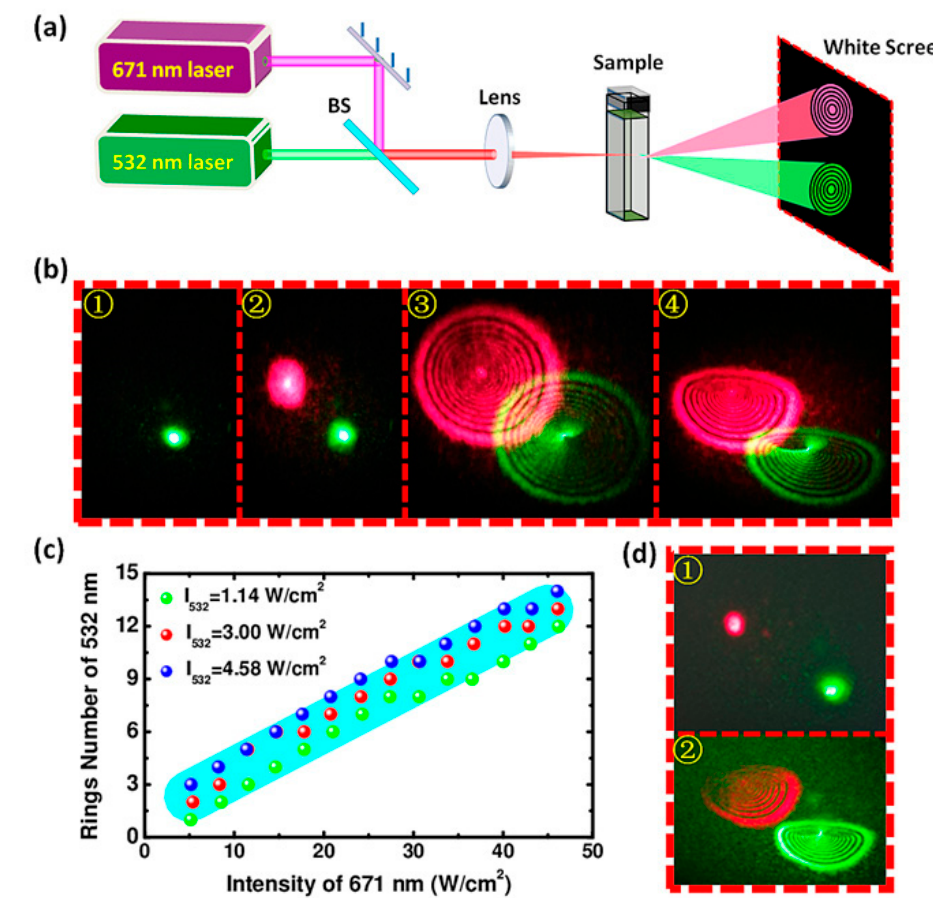
Figure 11. All-optical modulator based on spatial cross-phase modulation. ( a ) Schematic diagram of the experimental set-up. A total of two laser beams at 532 nm and 671 nm are utilized to be signal and pump light, respectively, and focused into the sample by a lens. The diffraction patterns of these two beams are captured on a screen by cameras. ( b ) Different evolution stages of diffraction rings during all-optical modulation. 1: Only weak probe light. 2: Strong pump light starts to interact with sample. 3: Diffraction rings excited by pump light. 4: Diffraction rings collapse from circular to sem- icircular rings. ( c ) Ring numbers of probe light as a function of pump intensity. ( d ) Diffraction pat- terns when the 532 nm laser serves as pump light to modulate the 671 nm laser. 1: Two beams start to interact with sample. 2: Final stable diffraction rings. [134].